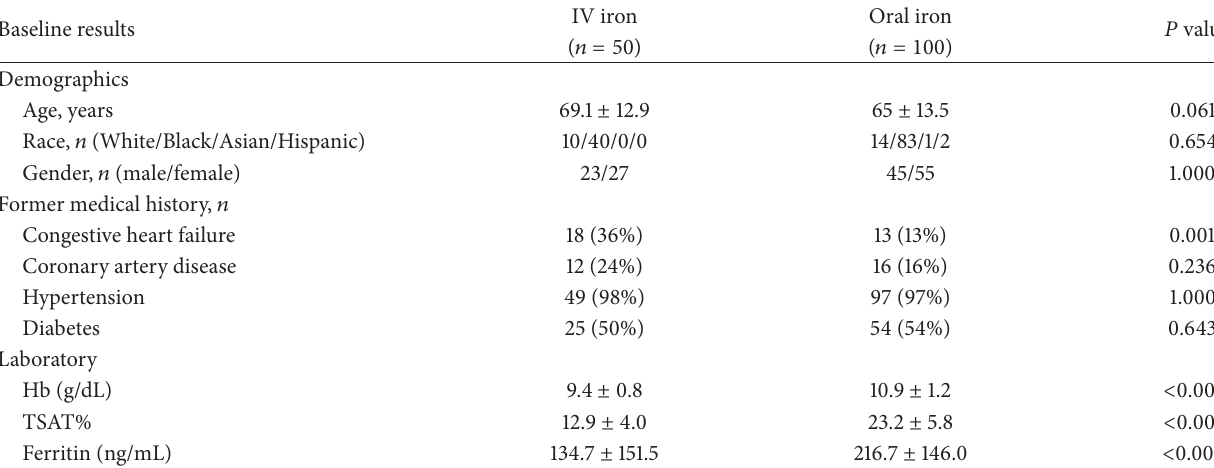
Table 1: Patient demographics and baseline characteristics.